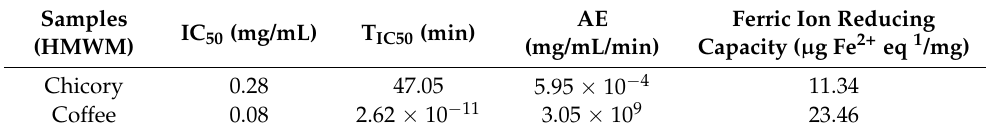
Table 3. Antioxidant activity of chicory and coffee high molecular weight material (HMWM) deter- mined in terms of IC 50 , T IC50 , antiradical efficiency (AE) and ferric ion reducing capacity.